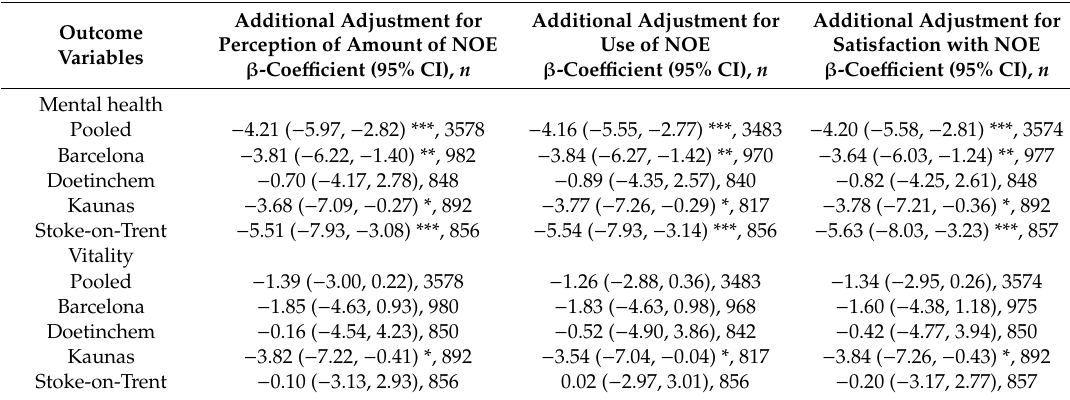
Table 9. Mixed e ff ects regression of childhood NOE exposure (low levels vs. high levels) on mental health and vitality (0–100 scales; higher scores indicate better mental health / vitality) with additional adjustments for the perception of amount of NOE, use of NOE, and satisfaction with NOE. Pooled and city-specific